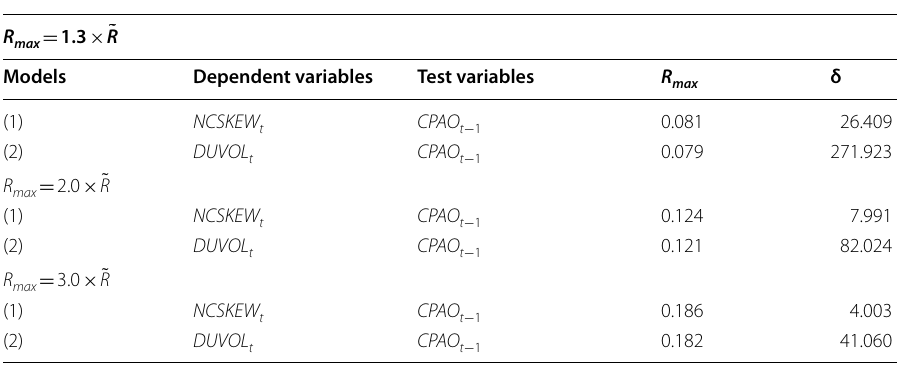
Table 5 Coefficient stability test (Oster’s δ) Oster’s